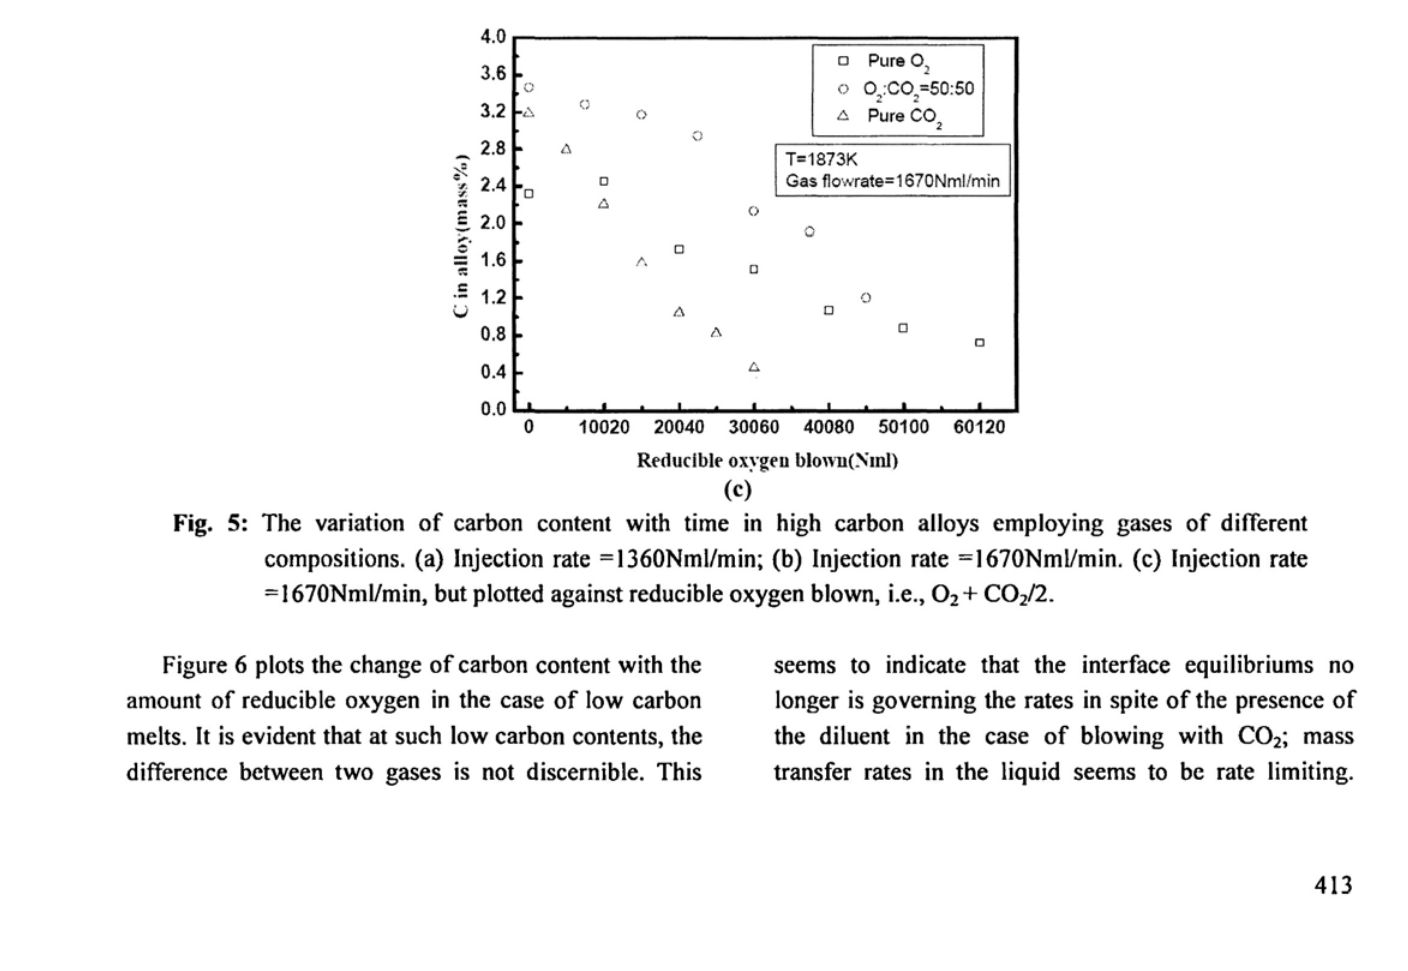
Fig. S: The variation of carbon content with time in high carbon alloys employing gases of different compositions, (a) Injection rate =1360Nml/min; (b) Injection rate =1670Nml/min. (c) Injection rate =1670Nml/min, but plotted against reducible oxygen blown, i.e., O